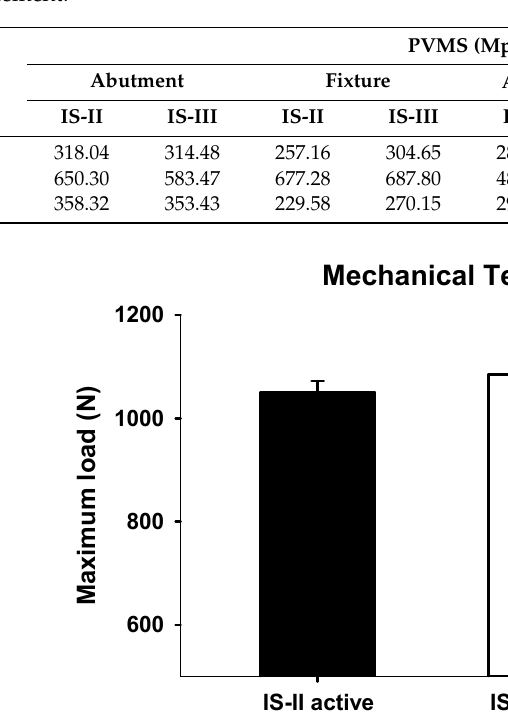
Figure 7. Cross-sectional view of the von Mises stress for single-tooth surgical FE models under various loading directions. ( a ) IS-II and ( b ) IS-III. Table 5. Peak von Mises stress (PVMS) results of IS-II and IS-III for the abutment, fixture, abutment screw, and cement.